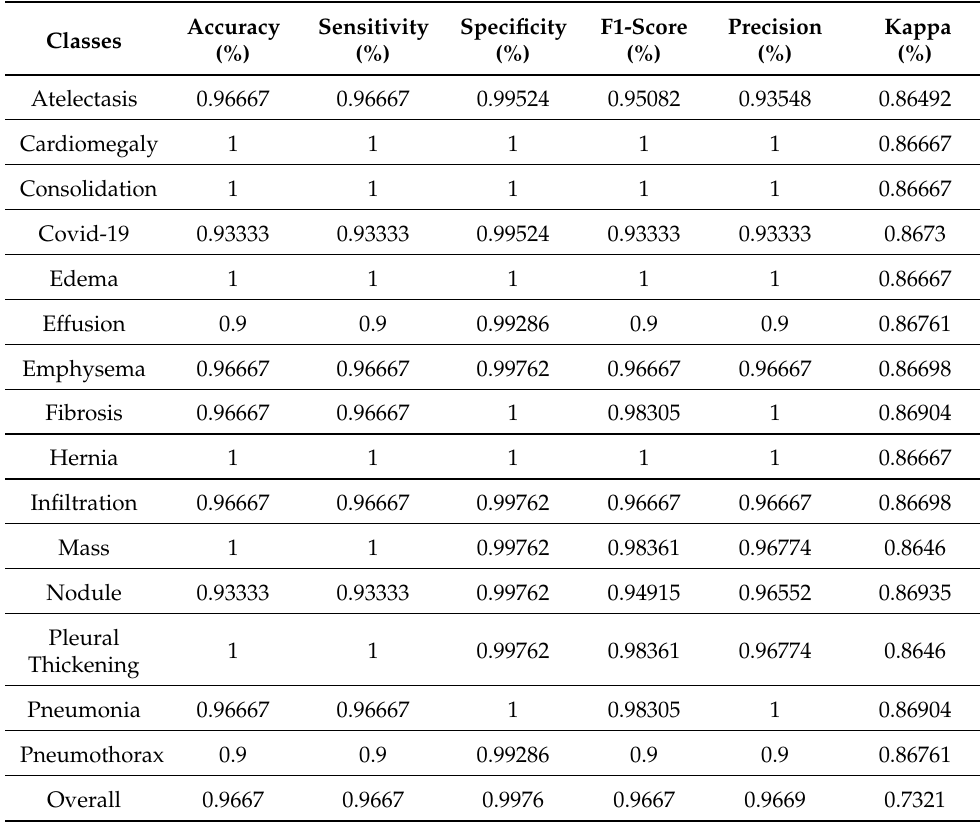
Table 5. CNN testing data